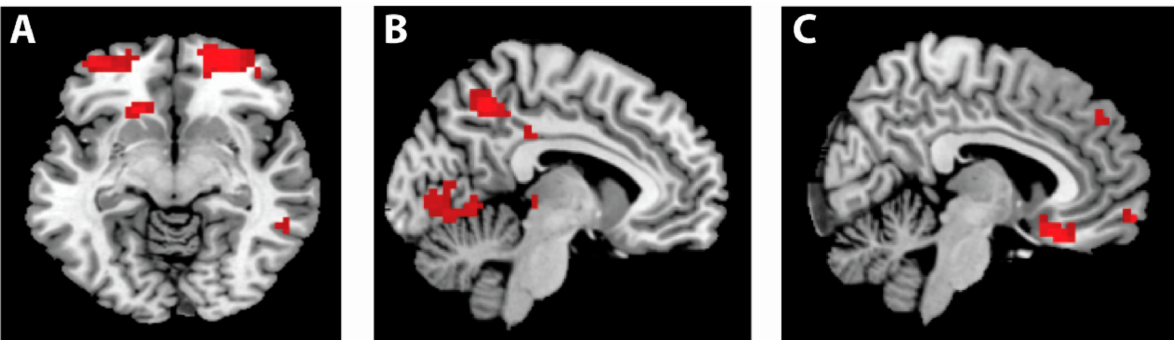
Figure 4. Neuroimaging results. ( A ). Bilateral lateral orbitofrontal cortex ( z = − 8) was activated more in trials in which incentives were absent vs. present (screen II). ( B ). Activation in the precuneus ( x = − 8) was associated with the absence of incentives during the moment of choice (screen V). ( C ). The right medial orbitofrontal cortex ( x = 6) showed more activation when social incentives could be received compared to financial incentives during the moment of choice (screen